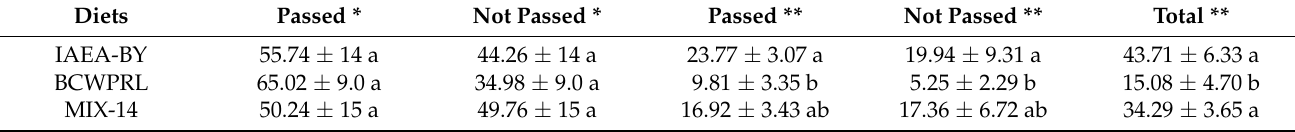
Table 2. The ratio (%) of sieved pupae collected 24 h after pupation onset compared to the total number of pupae collected the same day (passed and not-passed through the sieve) *, and the ratio of sieved pupae number to the initial number of eggs submitted to hatching **, after feeding with three larval